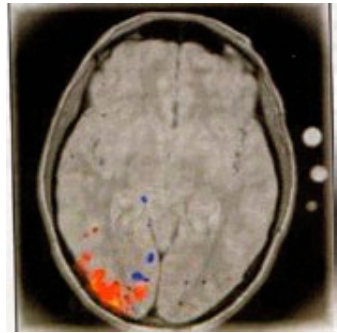
Figure 11. Brain activation (bright color) characterizing the func- tioning of anxious and depressed persons as they Process emotional information and respond to various types of positive and negative stimuli. Reproduced with permission of the Stanford Mood and Anxiety Disorder